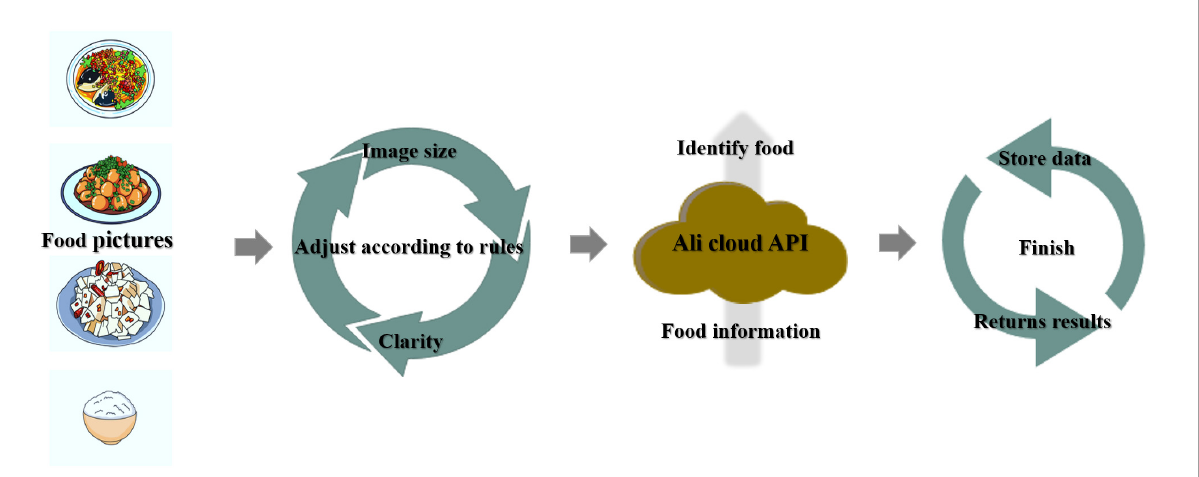
FIGURE2 Aliyun food recognition